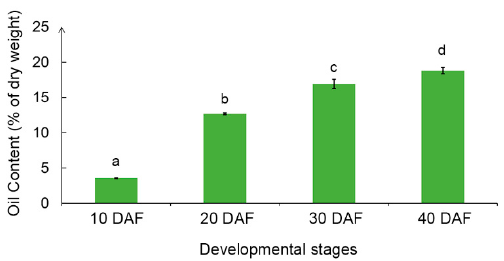
Figure 1. Total oil content in developing soybean seeds of NN1138-2 at 10, 20, 30, and 40 days after flowering (DAF). Different letters above the bars represent significant differences at 0.05 level by Fisher’s least significant difference (LSD) test. Error bars represent the standard deviation (SD) of means across three replications.